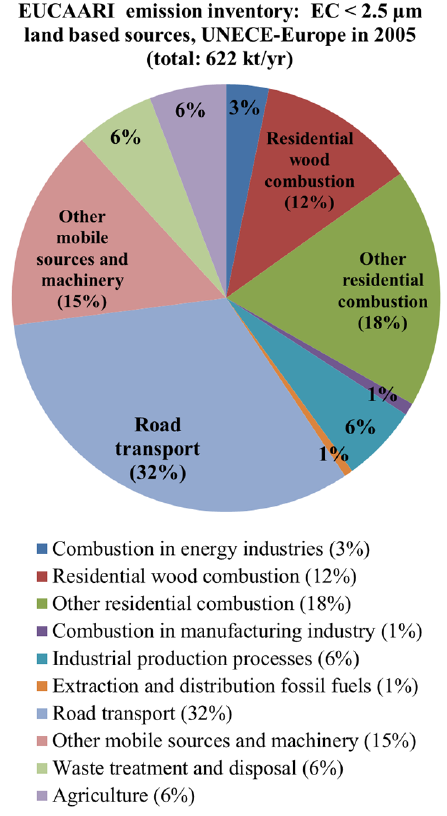
Fig. 8. Relative contribution from different source sectors to emissions of fine particulate elemental carbon (EC 2.5 ) in Europe in 2005, as estimated in the emission inventory developed within the EUCAARI project.